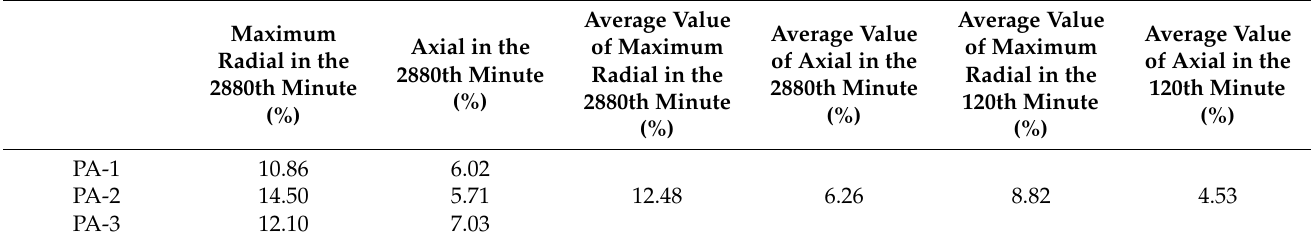
Table 3. Maximum radial free-swelling ratio.